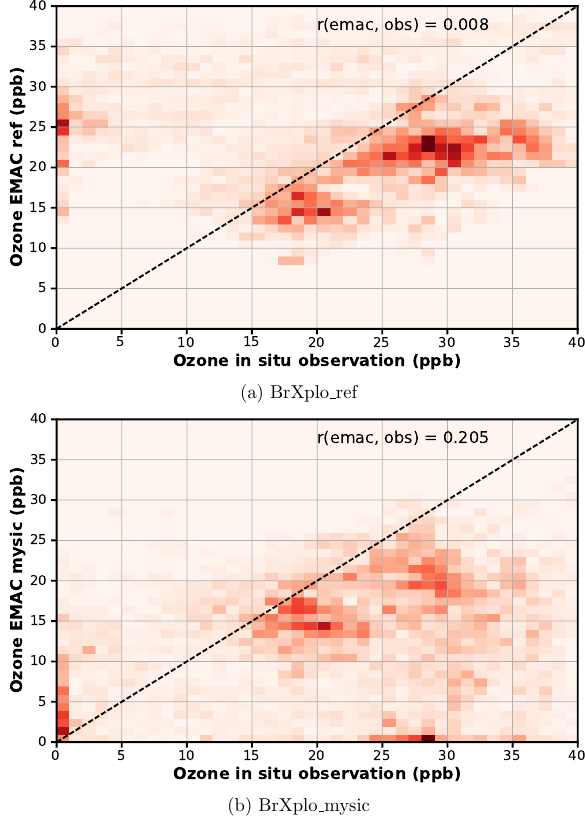
Figure 7. Temporal correlation of modeled surface O 3 with obser- vation at Utqia˙gvik. Data have been binned in bins of 1ppb width. While observed low ozone events at Utqia˙gvik are absent in the ref- erence simulation, in the BrXplo_mysic simulation there is now a population where both observation and model simultaneously show low ozone values, which is also reflected in the improved linear correlation coefficient from 0.008 to 0.21. (a) BrXplo_ref; (b) BrX-